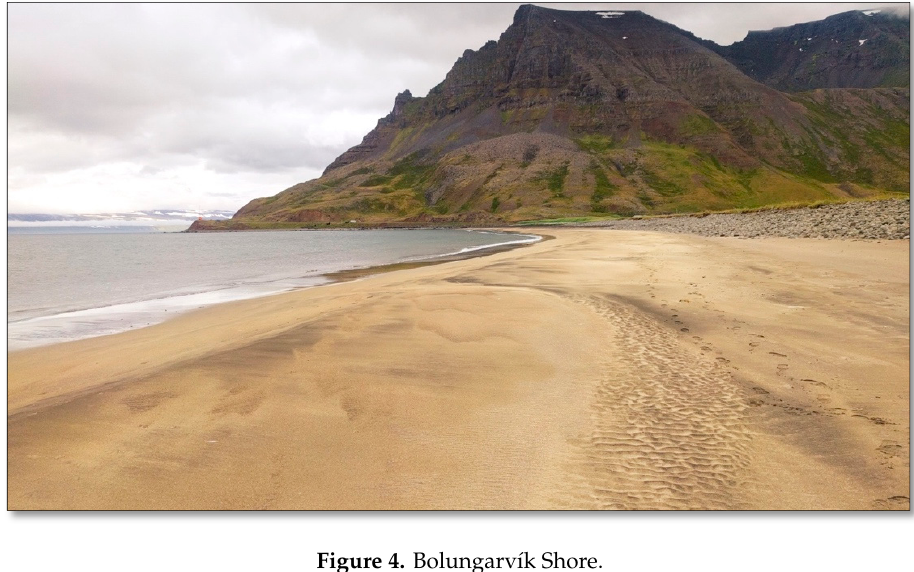
Figure 4. Bolungarvík Shore. Figure 4. Bolungarv í k Shore.